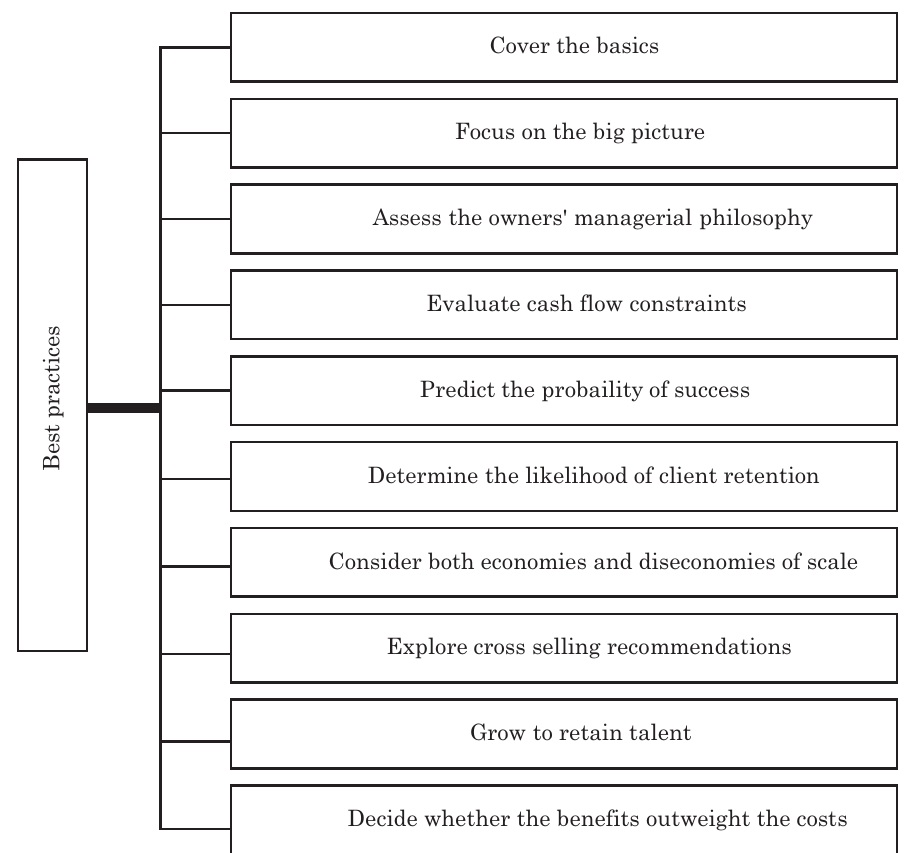
Fig. 2. Ten recommendations for evaluating fee management